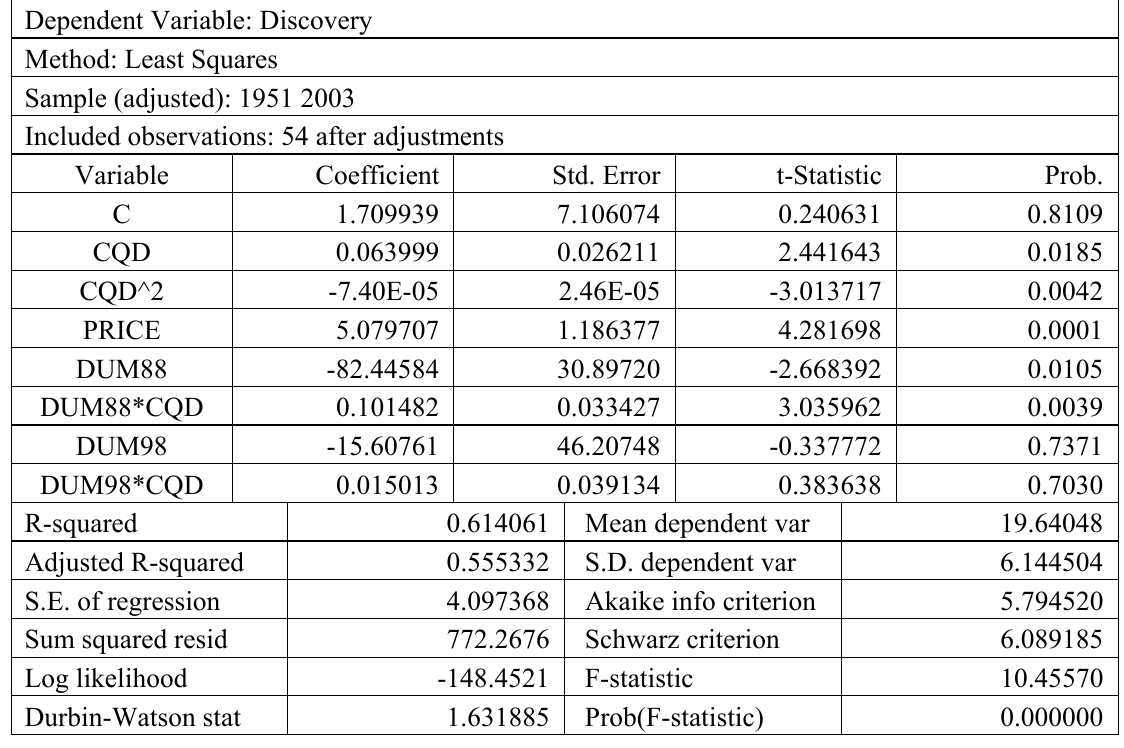
Table 10. Hubbert curve with price instead of Indicator